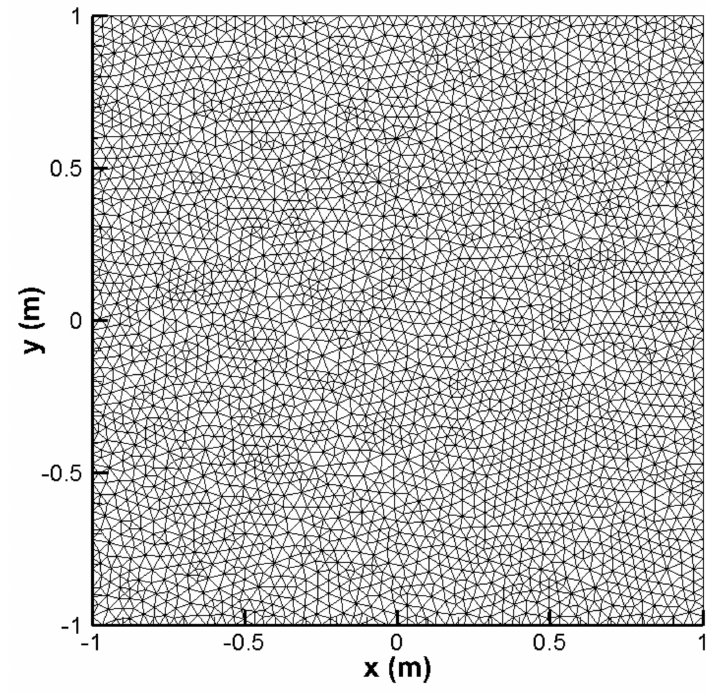
Figure 8. Computational mesh in the potential flow